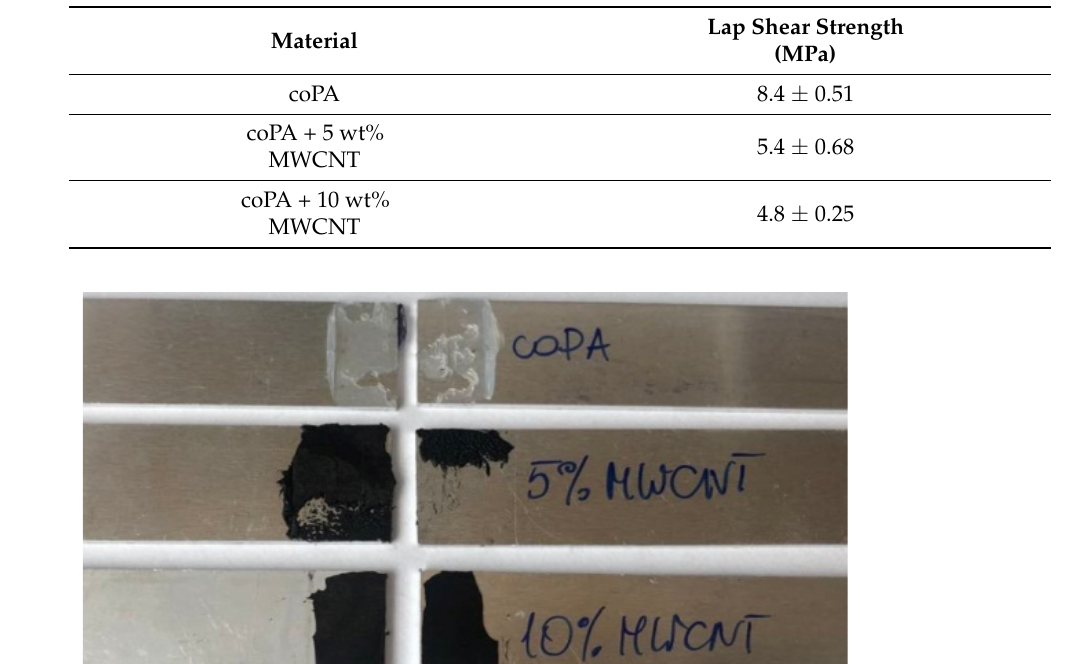
Table 4. The result of the lap-shear test.